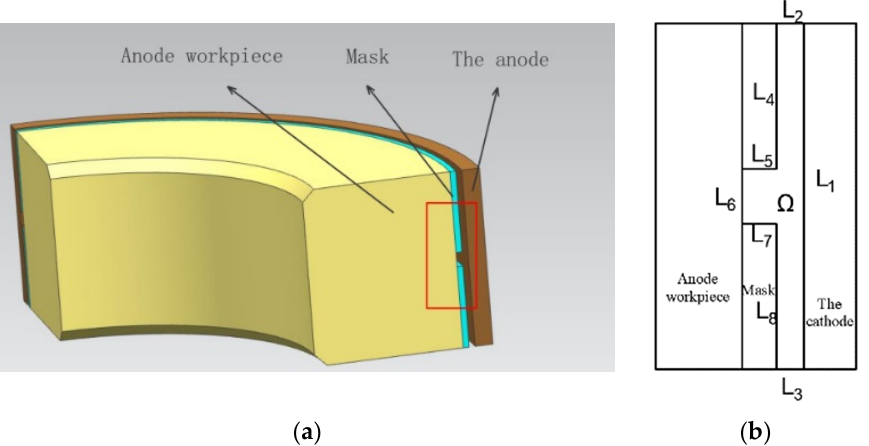
Figure 4. Machining area model of ring groove. ( a ) Three-dimensional model of ring groove machining; ( b ) Two-dimensional mathematical model.